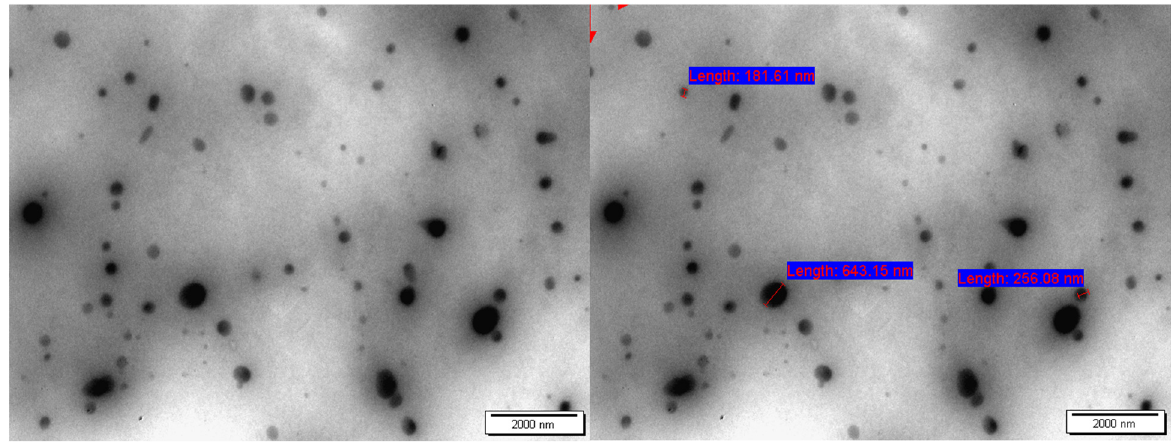
Figure 8. TEM images of the hyperbranched polyester.